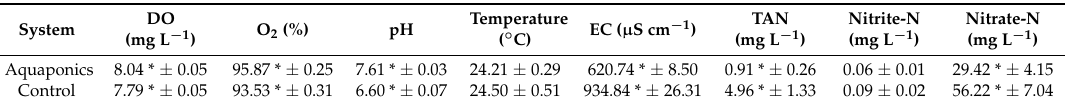
Table 1. Mean values ± SEM of water quality parameters; * significance ( p < 0.05). EC, electric conductivity; TAN, total ammonium nitrogen.